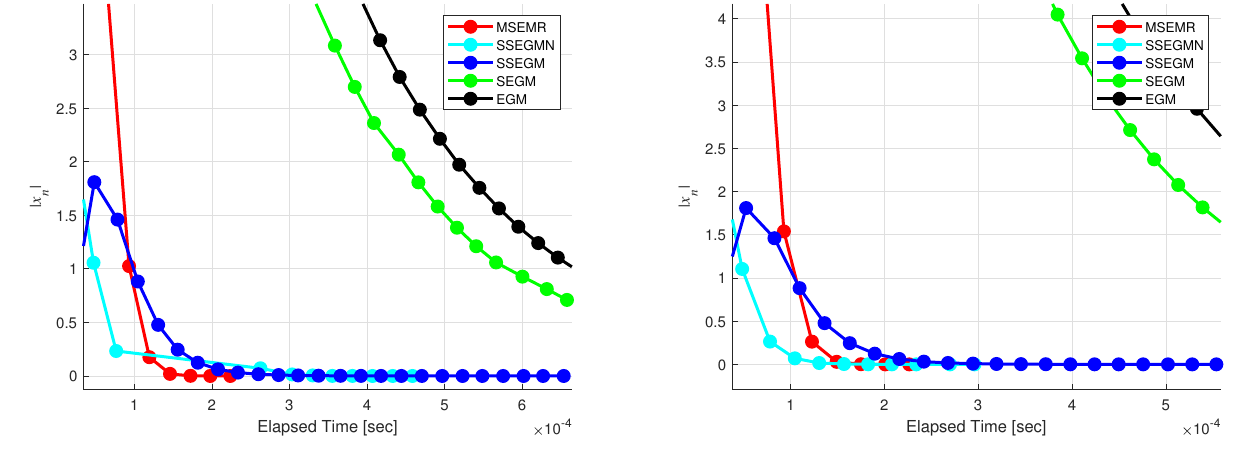
Figure 2. Example 3. Left: x 0 = 20 and x 1 = 16. Right: x 0 = 30 and x 1 =